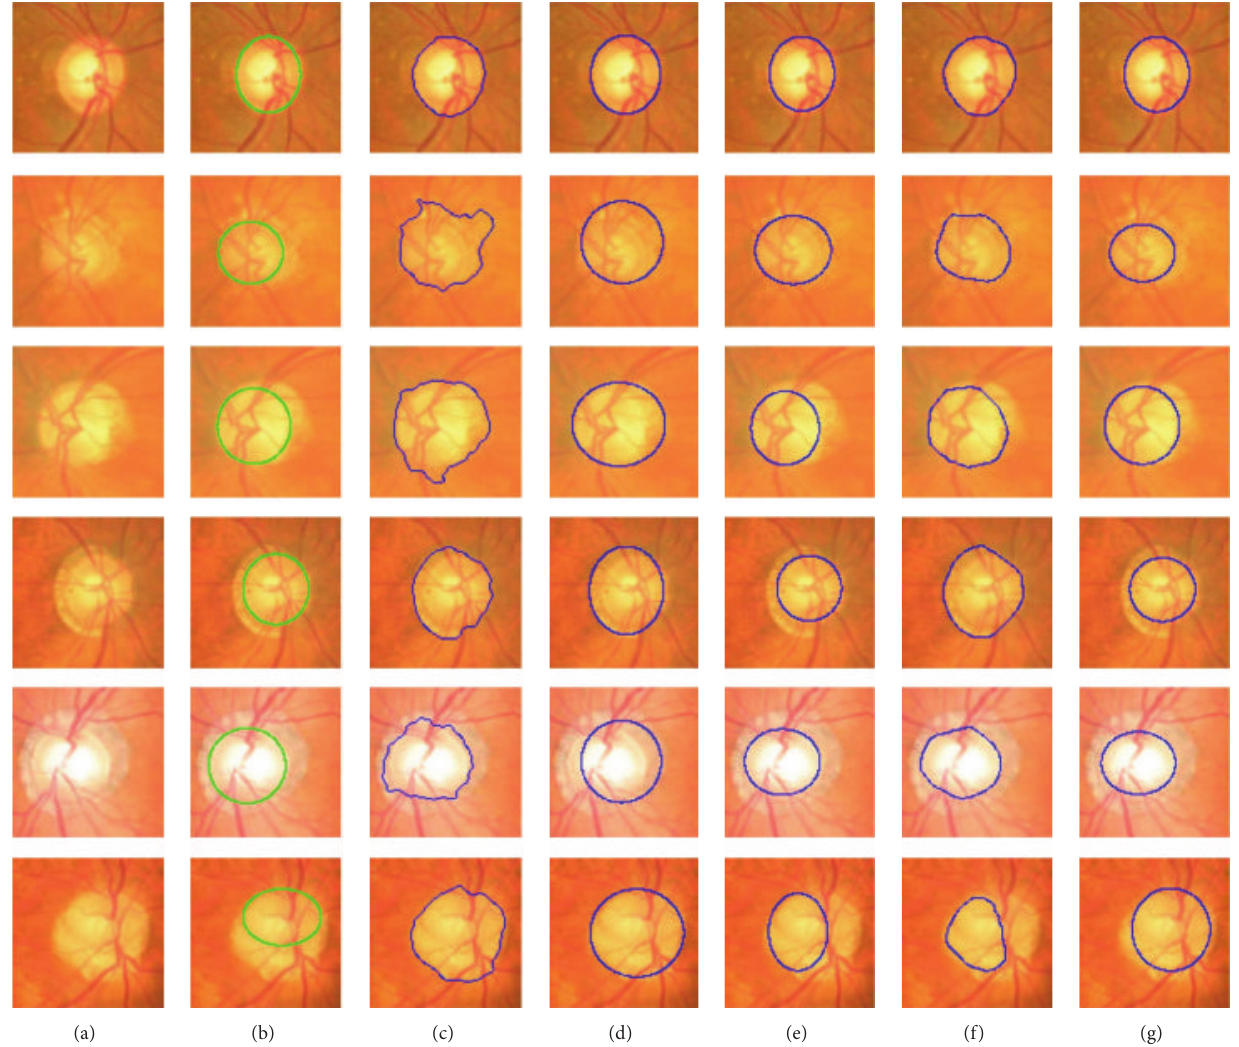
Figure 31: Sample results of the optic disc. From left to right columns: (a) the original images, (b) the manual “ground truth,” and ((c)–(g)) outlines by the MCV, CHT-ASM, EHT, and